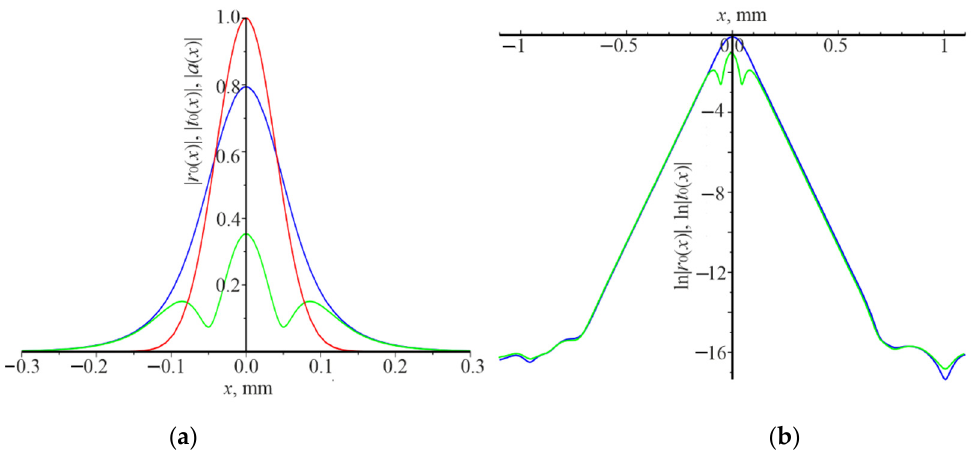
Figure 6. The distribution of the field amplitude along the x coordinate of the incident Gaussian beam | a ( x )| (red curve), reflected beam | r 0 ( x )| (blue curve), the transmitted beam | t 0 ( x )| (green curve) ( a ); ln| r 0 ( x )| (blue curve), ln| t 0 ( x )| (green curve) ( b ). Numerical calculations were carried out under the conditions d = 0.65 µ m, λ = 1.07 µ m, θ = 0, L = 0.1 mm. The distribution of moduli amplitudes of the reflected |𝑟 (cid:2868) (cid:4666)𝑥(cid:4667)| and the transmitted beams |𝑡 (cid:2868) (cid:4666)𝑥(cid:4667)|, as well as the natural logarithms of these quantities under the following resonance conditions 𝑑 = 0.78 μm, 𝜆 = 1.23 μm, 𝐿 = 1.5 mm, are presented in Figure 7.